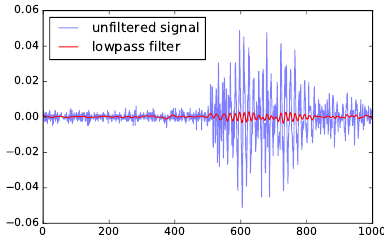
Figure 3. Low-pass filter could remove too much of the signal, an illustration with a series of high SNR (channel 1) data. The horizontal axis is time steps (where each step is 0.4 ns) and the vertical axis shows UHF measurements before and after filtering (in V).